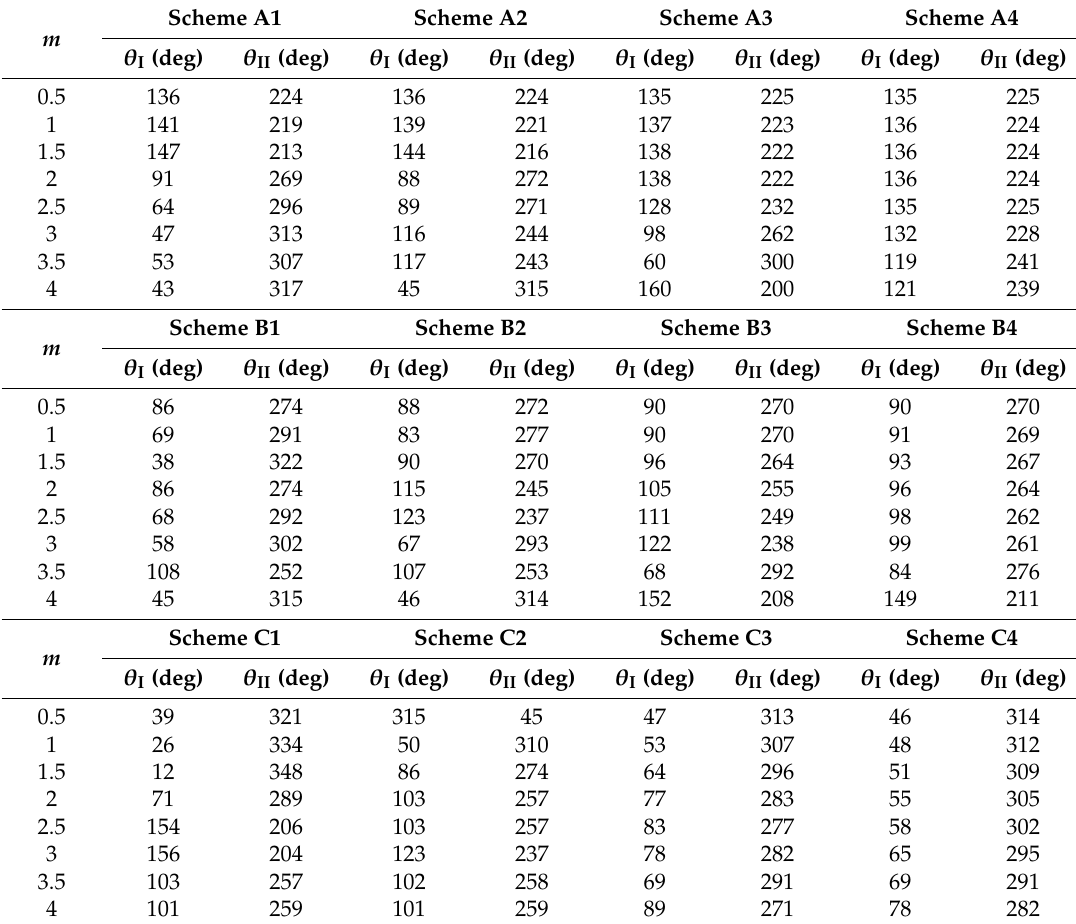
Table 4. Irregular θ I and θ II for all